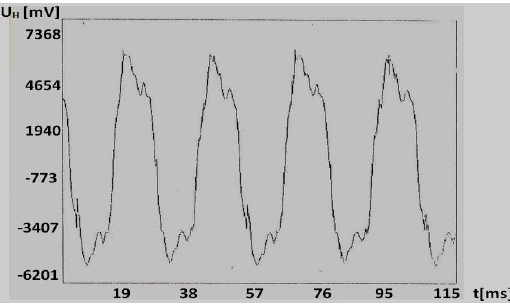
Figure 13. Hall voltage versus time in the case of the shorting of two commutator sectors, Hall sensors fixed on the rotor, loaded starter.